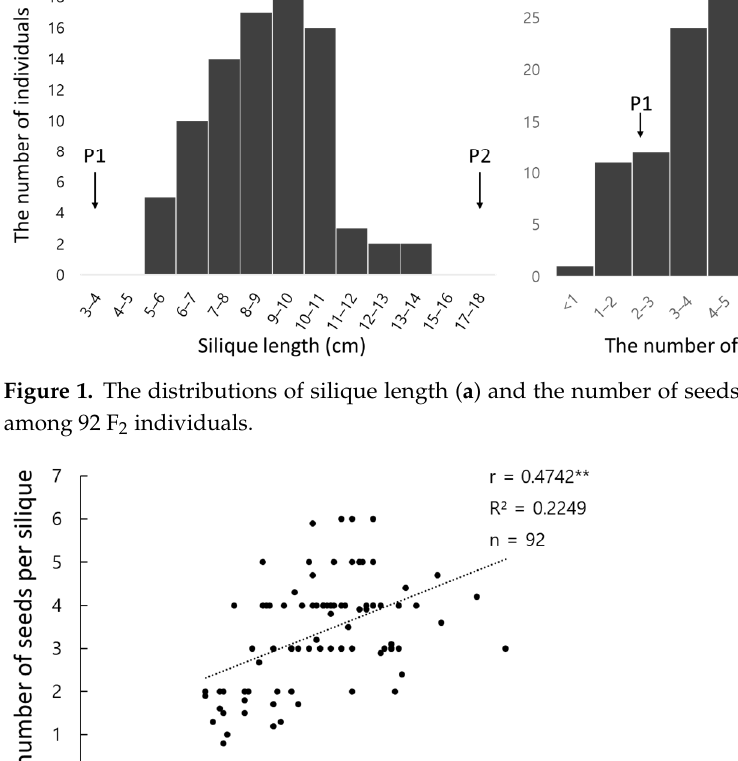
Figure 2. The correlation between the number of seeds per silique and silique length in radish among 92 F 2 individuals. ** indicates significant at p ≤ 0.01 level.